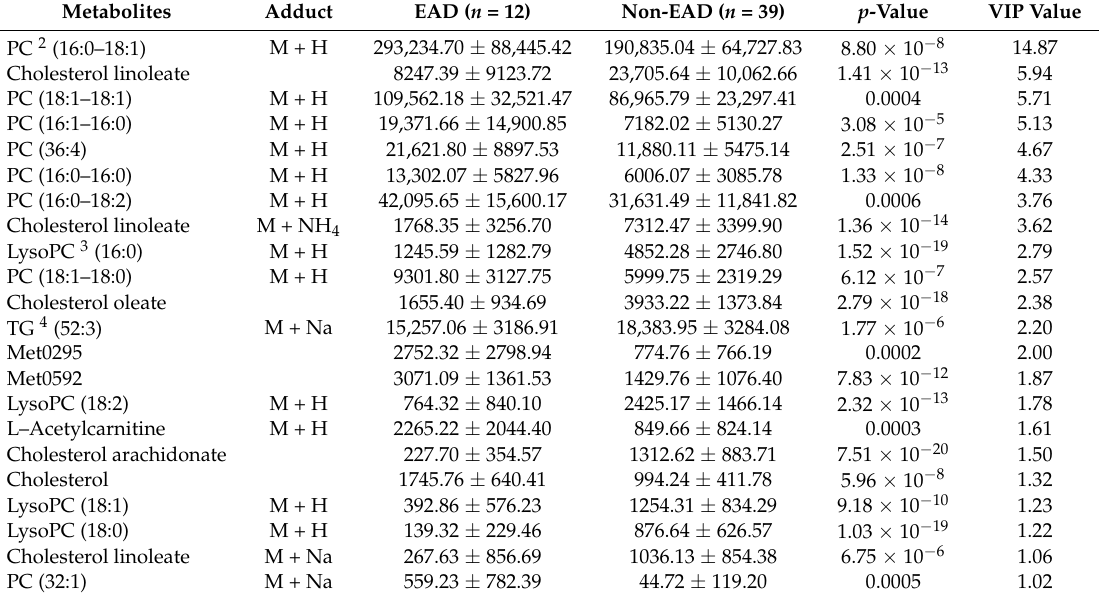
Table 4. A List of metabolites that discriminated the EAD 1 from the non-EAD 1 groups (VIP > 1.0 & p < 0.001).